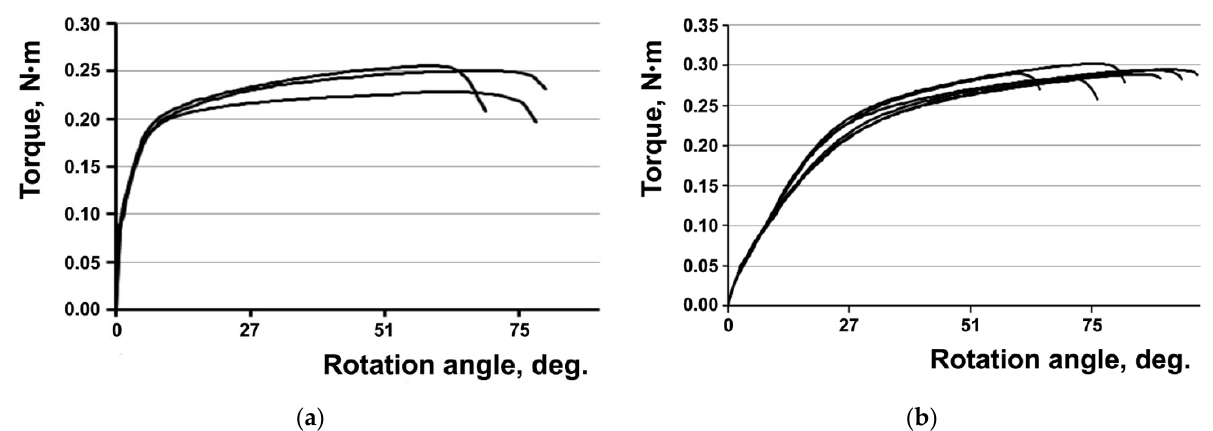
Figure 9. “Torque—rotation angle” diagrams based on the torsion tests of the screws from CG ( a ) and UFG ( b ) Ti. Table 6. Average values of the parameters of screw fracture during torsion.